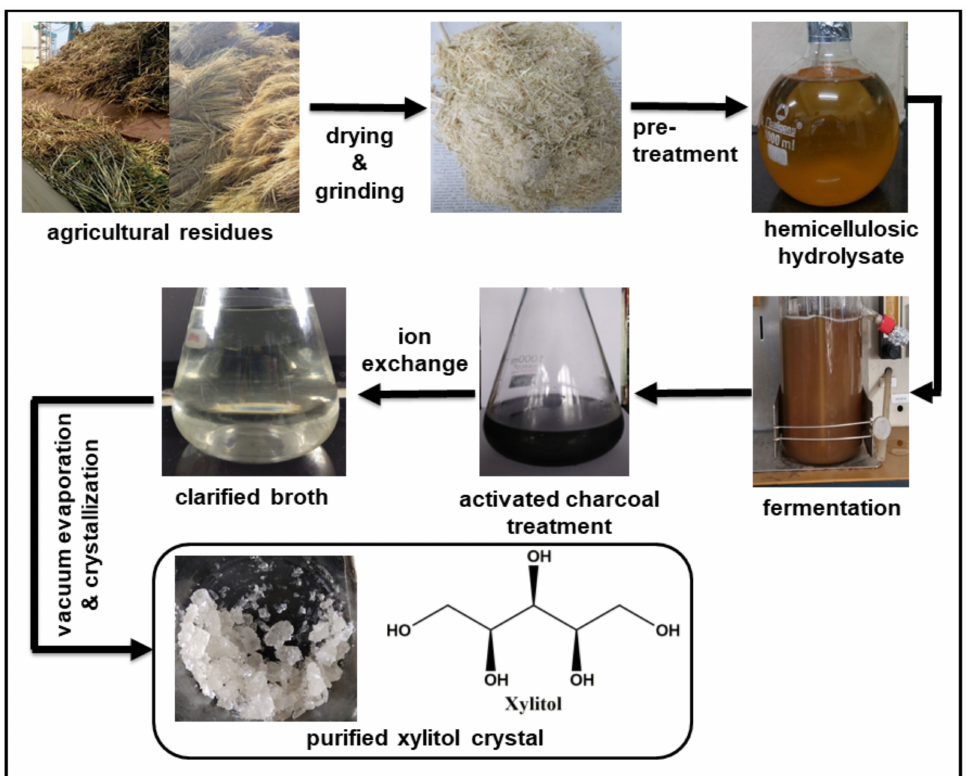
Figure 3. Processing of lignocellulosic biomass for xylitol production. Agricultural residues are dried and grounded to obtain coarse powder, which is treated with chemical / biological reagents to obtain hemicellulosic hydrolysate. Microorganisms ferment the hydrolysate to various byproducts such as xylitol. After fermentation, broth is treated with activated charcoal and ion exchange resins to remove the contaminants, and xylitol crystals are obtained after lyophilization of clarified